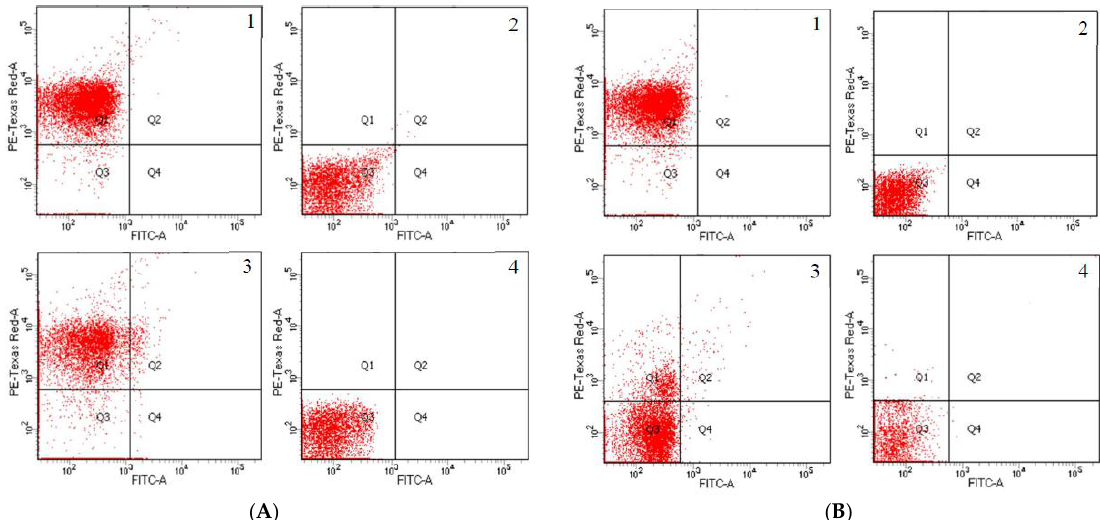
Figure 5. Transconjugants quantified using FCM in gene transfer system: Data set up are Q 1 for rfp events, Q 2 for double positive of rfp and gfp events, Q 3 for auto fluorescence of negative events, and Q 4 for gfp events. ( A ) sole recipient system (Tests 5# and 7#), ( B ) multi-recipient system (Tests 6# and 8#), (1) donor P. putida ( RP4) (RP4::Plac::gfp), (2) recipient, A3 sample in Test 7# at 180 min, B3 sample